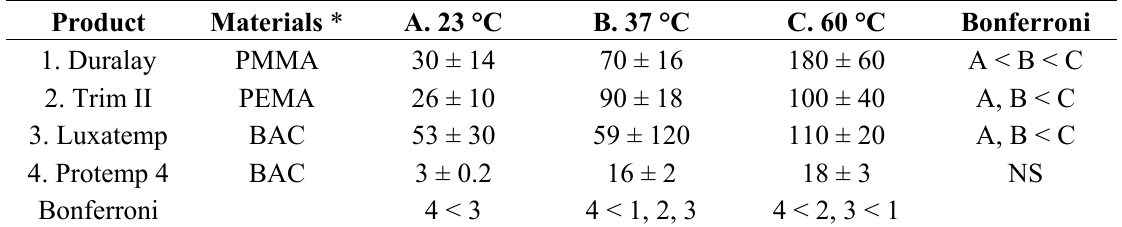
Table 3. Surface roughness (Ra) (nm) (±SD) of the materials and curing temperatures.